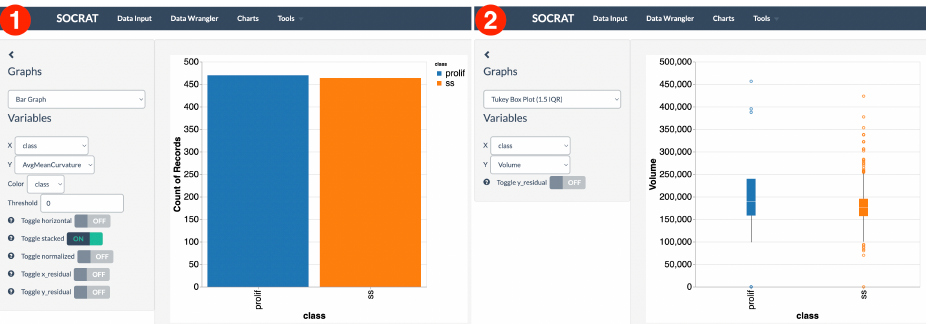
Figure 9. Interactive visualizations of cell morphology measures: ( 1 ) bar chart showing proportions of cells in the dataset per cell phenotypic class; ( 2 ) box plot showing the volume distributions of cell nuclei per treatment